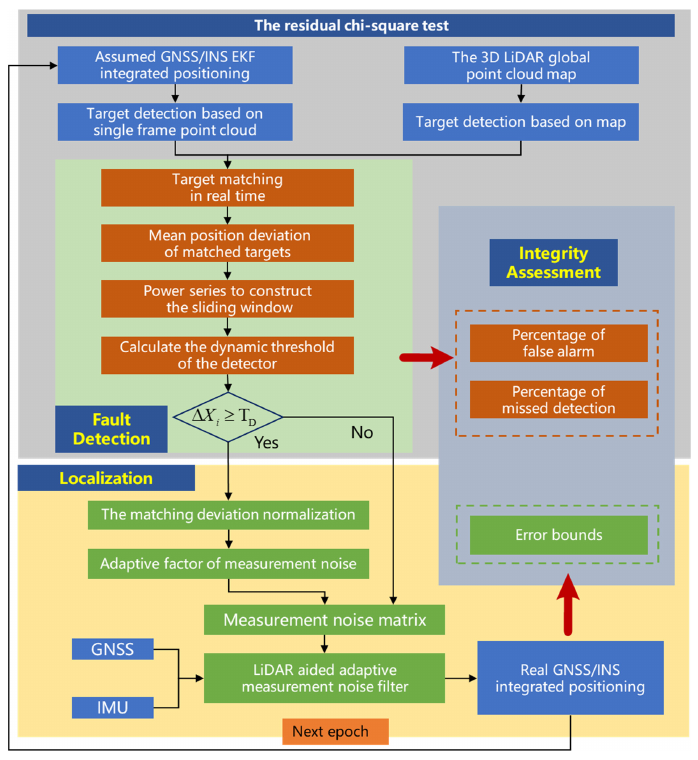
Figure 1. System framework of the proposed algorithm.